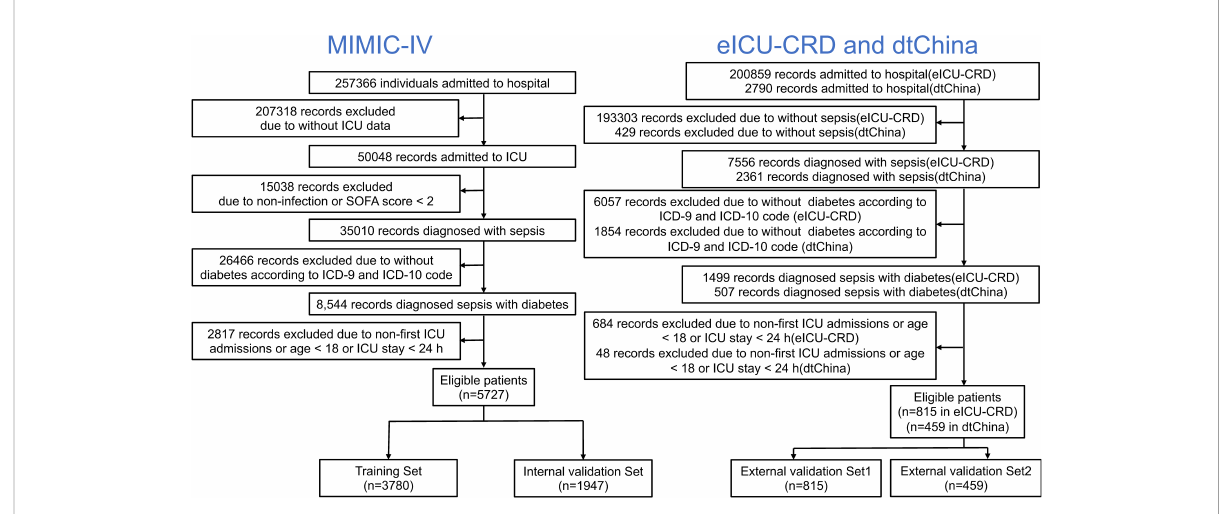
FIGURE 1 Flow chart depicting number of patients who were included in analysis after exclusion criteria. A total of 7001 records were